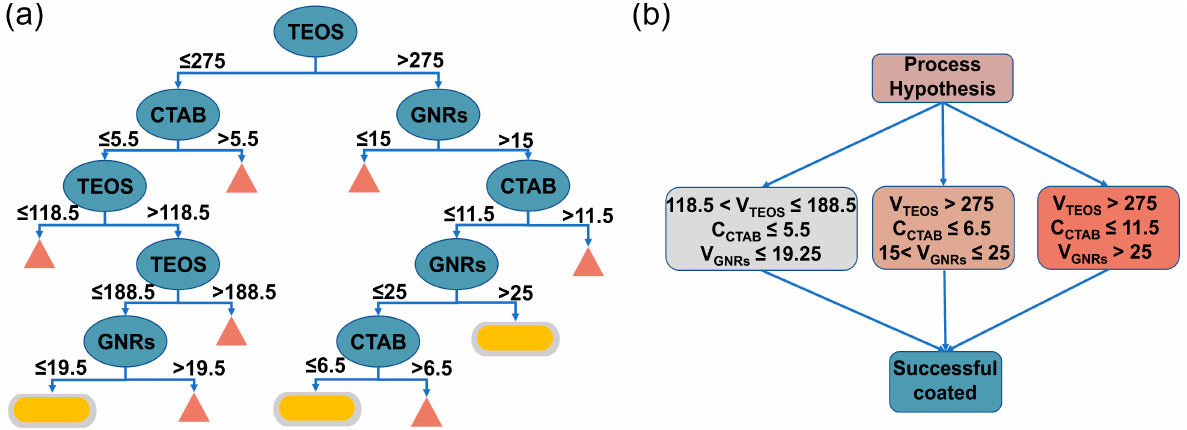
Figure 2. ( a ) Decision trees derived from the XGBoost model were used to classify successful and unsuccessful outcomes in silica-coated gold nanorod preparations. Ovals, triangles, and cylindricals signify decision nodes, excised subtrees, and result bins, respectively. ( b ) Graphical representation of the three process hypotheses extracted from the decision tree.